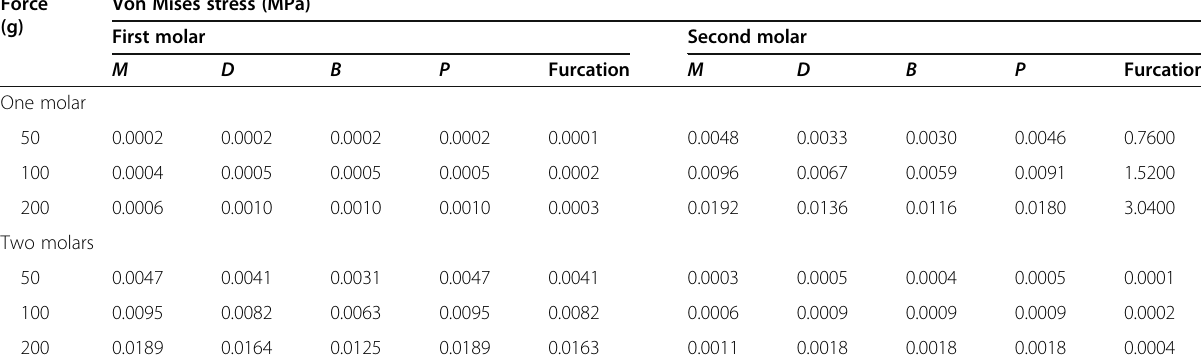
Table 2 Value of maximum von Mises stress in the PDL of posterior teeth (MPa) Force (g)